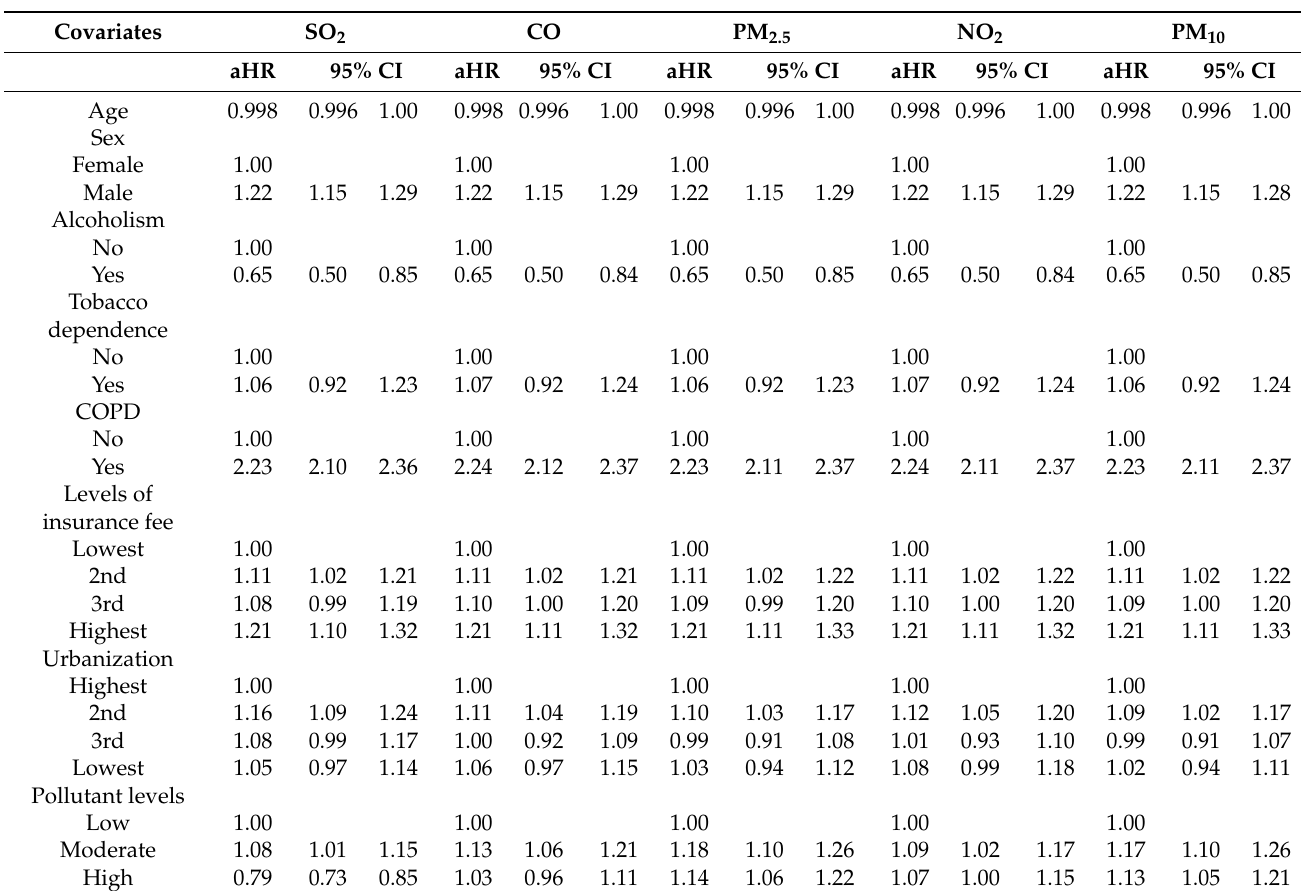
Table 3. Adjusted HR of CRS in the moderate and high concentration groups compared to that in the low concentration